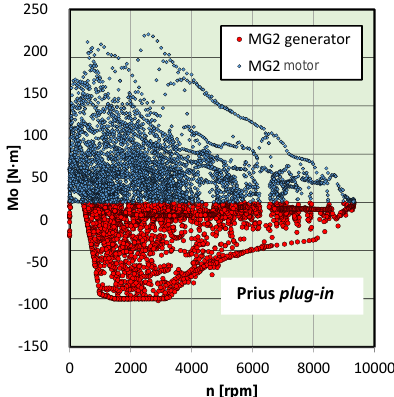
Fig. 12. Conditions of electric motors operation for engine and generator mode of operation [3]